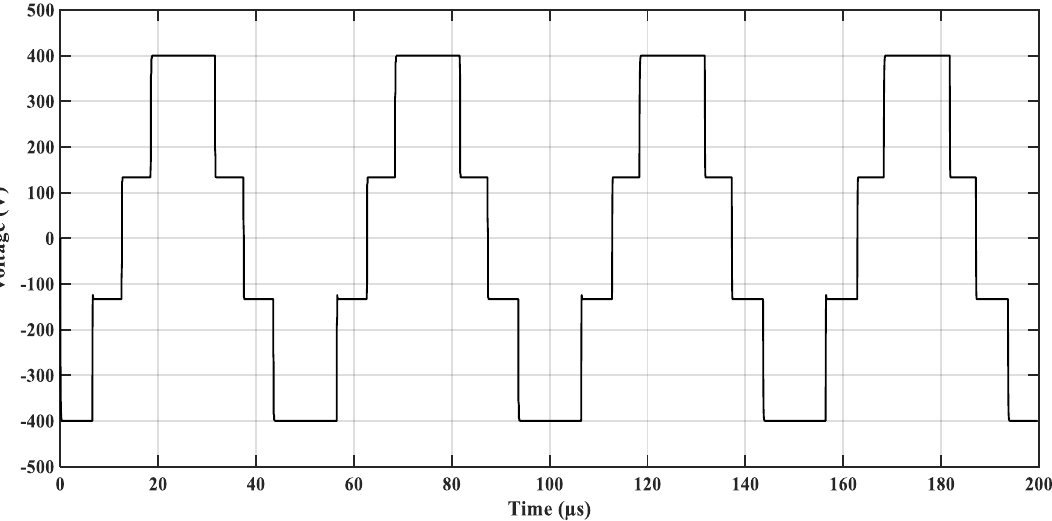
Figure 7. Compensating voltage of common-mode transformer.